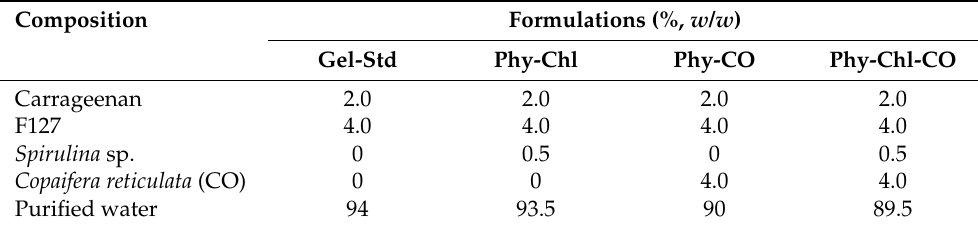
Table 1. Composition of the topical